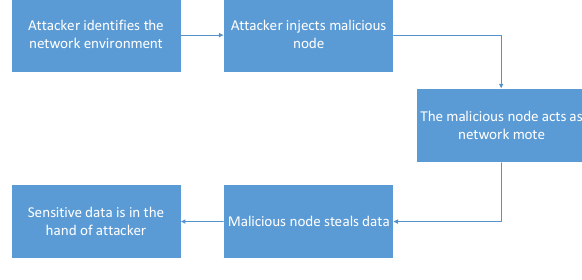
Figure 5. The rank attack scenario.